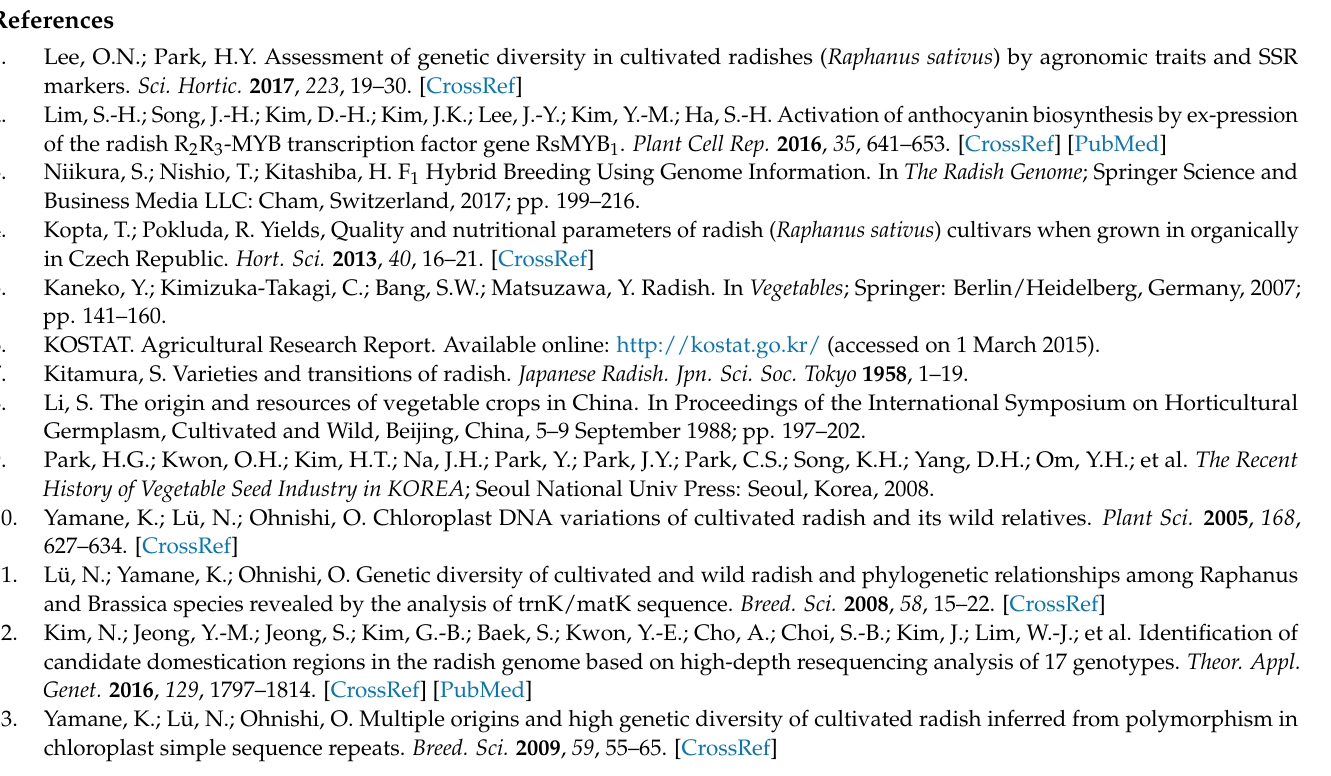
Linkage map and SNP position from the GBS. Each linkage group is matched to the chromosomal pseudomolecule sequence, as indicated above the plot. Positions of SNP markers are indicated as black horizontal line along the linkage groups. Figure S3: Comparison of the GWAS results with those of previous QTL mapping reported in Yu et al. (2013). (a) One SNP (GBS-FW37) located in intergenic region of chromosome 2 were closely localized with qFW6 ; (b,c) one SNP (GBS-FW39) located in intergenic region on chromosome 5 and three SNPs (GBS-FW20, 21, 22) located in genic region of chromosome 6 were co-located with FW resistance QTL ( qFW4 ); (d) one SNP (GBS-FW33) located in genic region of chromosome 9 were closely located with qFW7 . Table S1: List of 225 radish accessions and cluster position of every accession. Table S2: Significant SNPs located in intergenic region with Fusarium wilt resistance detected by GWAS. Table S3: Potential candidate genes located in the 30 kb upstream and downstream region of the SNPs associated with Fusarium wilt of radish. Table S4: Disease-related genes identified 225 kb upstream and downstream of the SNP loci associated with Fusarium wilt of